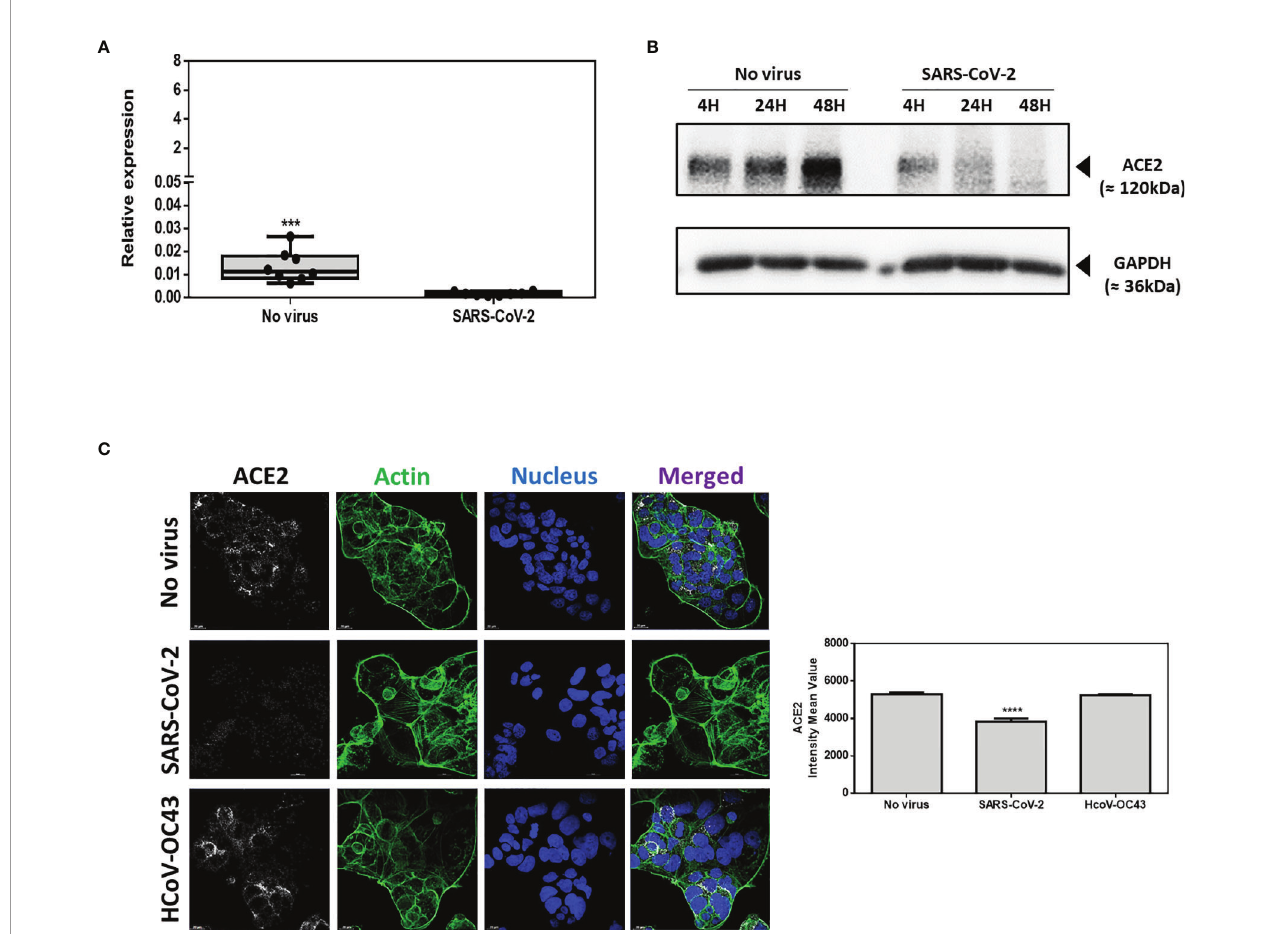
FIGURE 3 | ACE2 expression on Caco-2 cells. (A) ACE2 mRNA in virus-free Caco-2 cells or cells exposed for 24h to SARS-CoV-2 or HCoV-OC43 at MOI of 0.5. The results are expressed as RE where RE = 2 ( − D CT) . (B) Time course (4h, 24h, 48h) Western blot analysis of ACE2 proteins expression in virus-free Caco-2 cells or cells exposed to SARS-CoV-2 at an MOI of 0.5. (C) Illustration of single plane confocal microscope analysis of ACE2 expression on Caco-2 virus-free cells or cells exposed for 24h to SARS-CoV-2 or HCoV-OC43 at MOI of 0.5. The analysis was performed on unpermeabilized cells. Actin expression was shown as control as well as the labeling of the nucleus (left panel). Quantitative representation (n=4) of mean fl uorescence intensity corresponding to ACE2 protein expression on Caco-2 cells infected or not with SARS-CoV-2 or HCoV-OC43 (right panel). The symbol ****means a p-value < 0.0001; The symbol *** means a p-value